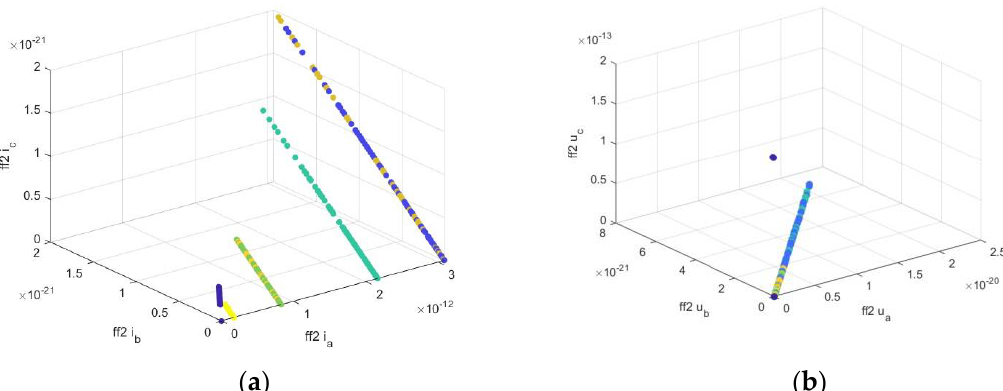
Figure 15. Dependence of the second-order harmonic amplitude of the fast Fourier transform of the